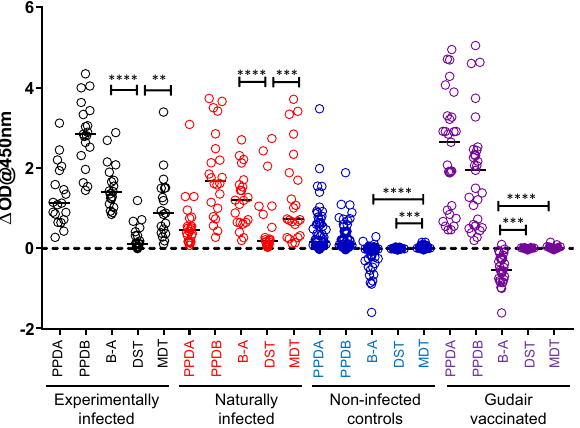
Figure 2. Quantification of MDT and DST induced in vitro IFN-γ production. Blood samples from cattle experimentally infected with M. bovis ( n = 22), cattle naturally infected with M. bovis (n = 21), naive controls ( n = 59) and Gudair vaccinates (n = 29) were stimulated in vitro with PPDs, DST and MDT reagents and IFN-γ production measured by ELISA. Each symbol represents an individual animal while horizontal lines represent